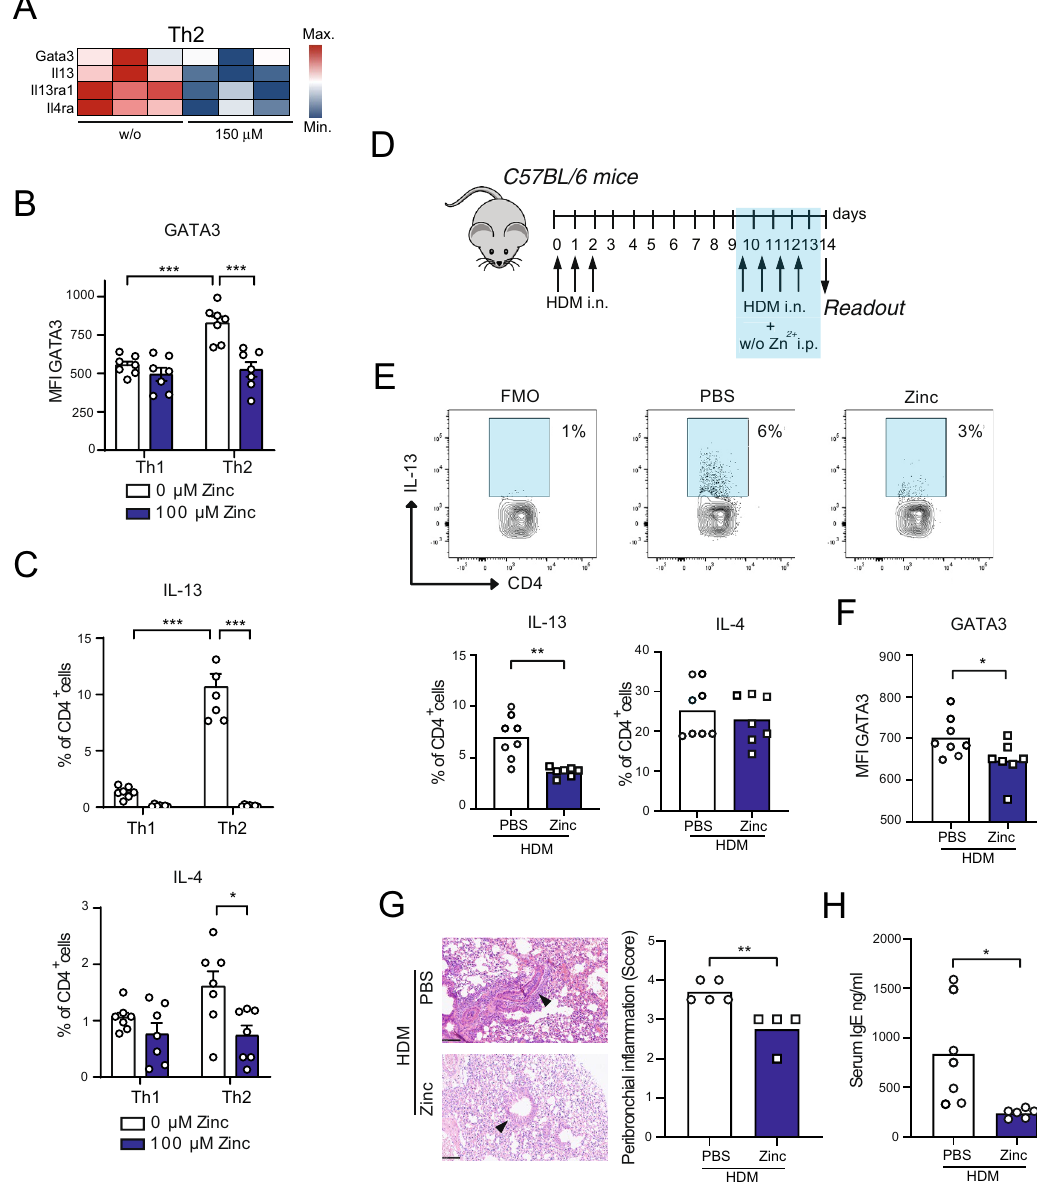
Figure 6. Zinc impairs Th2 house dust mite-induced asthmatic airway inflammation. ( A ) Heatmap showing Th2 genes of OT-II TCR tg CD4 + T cells in the absence and presence of 150 μM zinc. ( B ) MFI of GATA3 measured by FACS of OT-II TCR tg CD4 + T cells differentiated into Th1 and Th2 cells in the absence and presence of 100 μM zinc aspartate. ( C ) Frequencies of CD4 + IL-13 + and CD4 + IL-4 + cells measured by FACS after Th1 and Th2 differentiation in the absence and presence of 100 μM zinc aspartate. ( D ) Mouse model of Th2 asthmatic airway inflammation induced by house dust mite (HDM) extract. ( E ) Frequencies of lung CD4 + IL-13 + and CD4 + IL-4 + cells measured by FACS in the mouse model shown in Fig. 3D at day 14. ( F ) MFI of GATA3 in lung CD4 + T cells measured by FACS in the mouse model shown in Fig. 3D at day 14. ( G ) Peribronchial inflammation in the lungs from mice of the HDM asthma model shown in Fig. 3D ad day 14. ( H ) Total IgE serum levels of mice from the HDM asthma model shown in Fig. 3D ad day 14. RNA sequencing data in ( A ) was generated in biological triplicates from 3 mice. Statistical analysis in in ( B ) and ( C ) and ( E – H ) by unpaired student’s t test. Dots represent individual mice. Data are from 3 ( B , C ) and 2 ( E – H ) experiments. *p < 0.05, **p < 0.01, ***p <